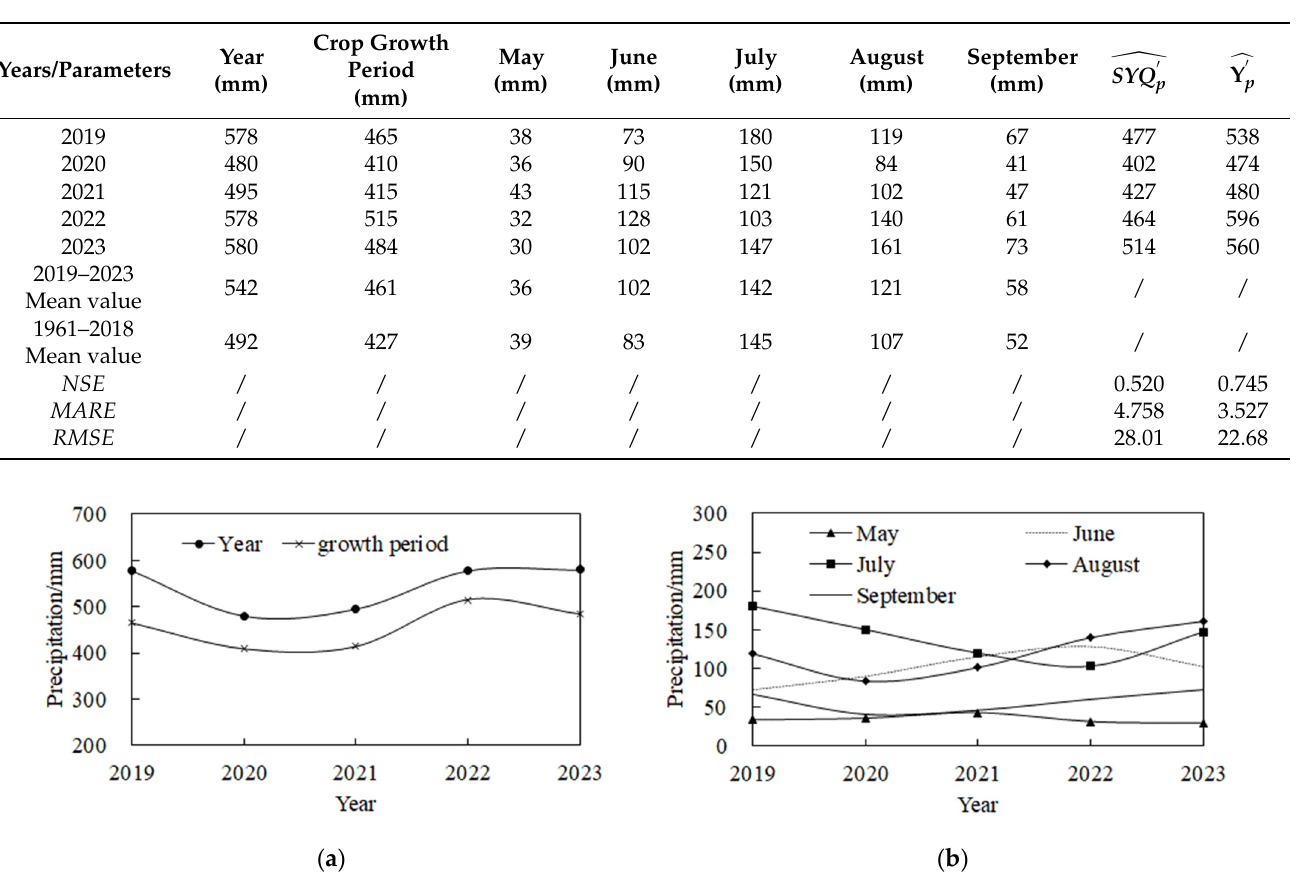
Table 4. Forecasting results and precision analysis of precipitation at different time scales from 2019 to 2023.